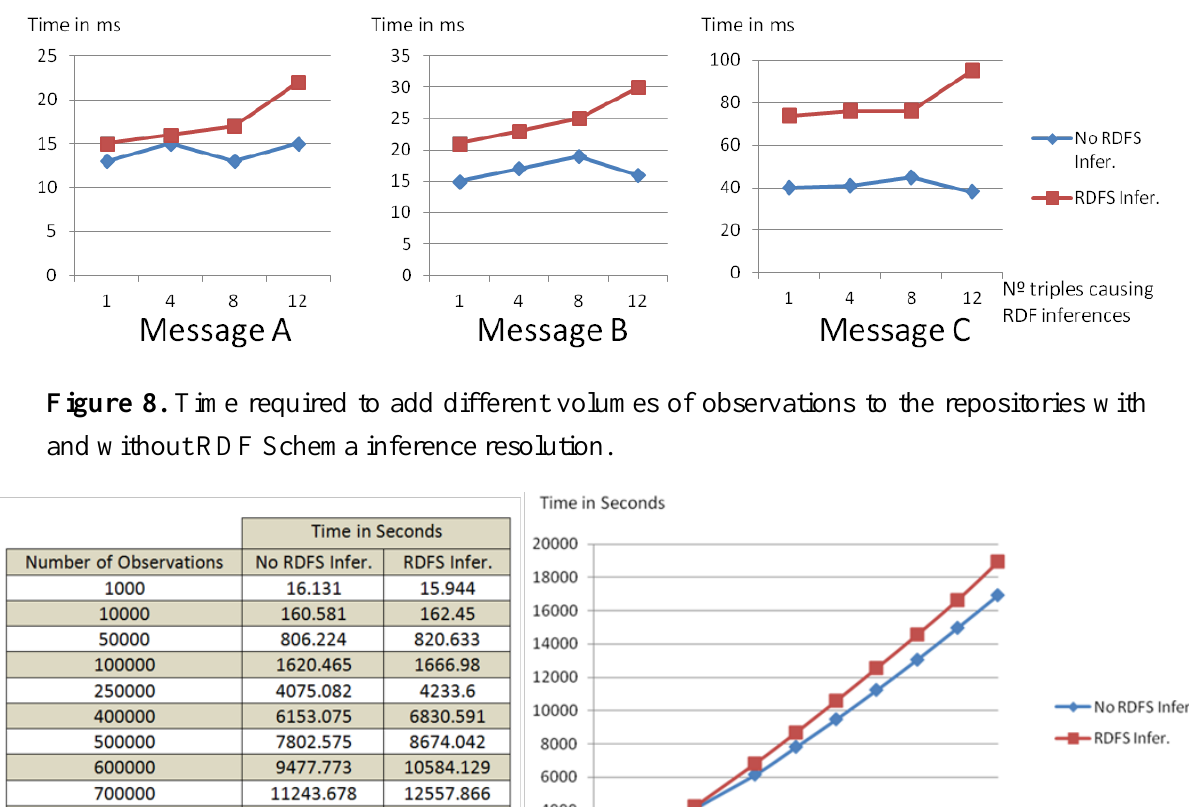
Figure 7. Publishing times for different types of messages, and for publication with and without RDF Schema Inference.